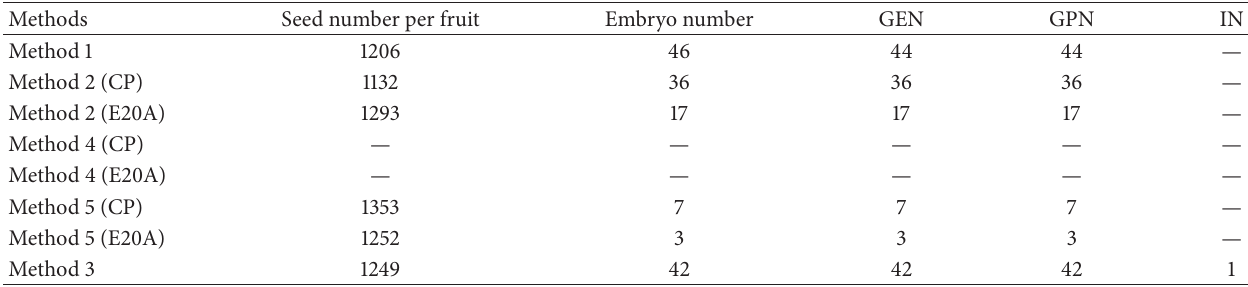
Table 1: Comparison of seed number per fruit, embryo number, the number of embryos transforming into plant, the number of developed plants, and amount of infection in melon according to methods (Figure